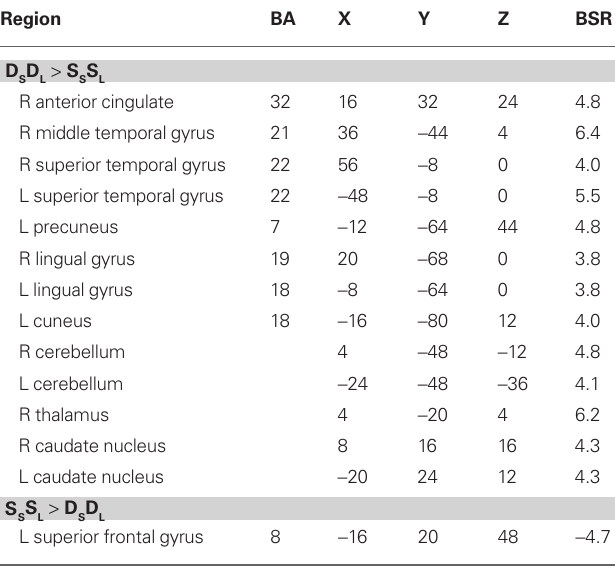
Table 2 | Brain regions with non-specific adaptation in young and older